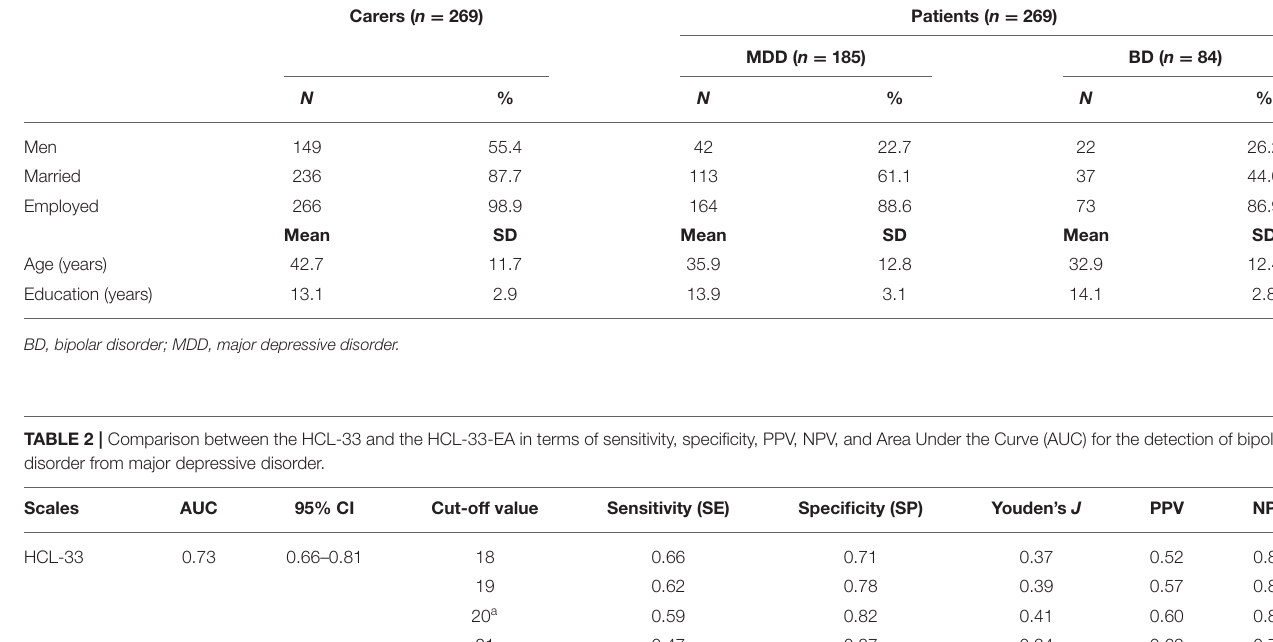
TABLE 1 | Characteristics of patients with mood disorders and their carers. Carers ( n = 269) Patients ( n = 269)